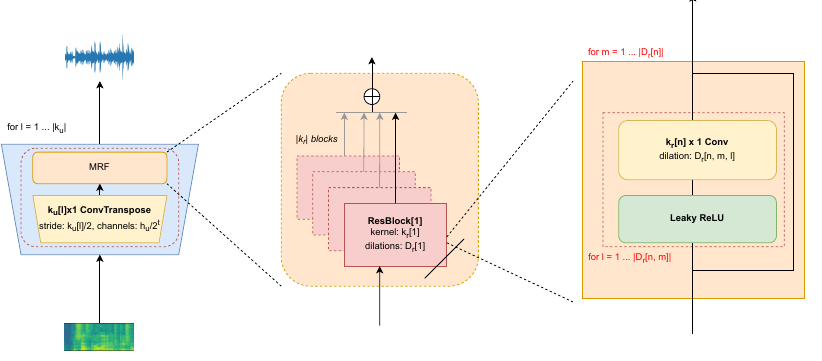
Figure 4. The structure of the HiFi-GAN